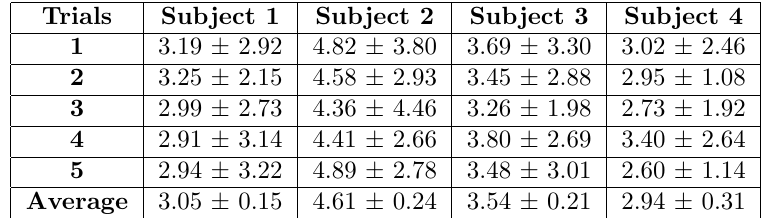
Table 3: RMS ( ± standard deviation) discrepancies between the video-based and EOG-based angular displacement peaks during each saccade-phase. If all trials are pooled across subjects, the average discrepancy is 3.54 ± 0.71. All units are